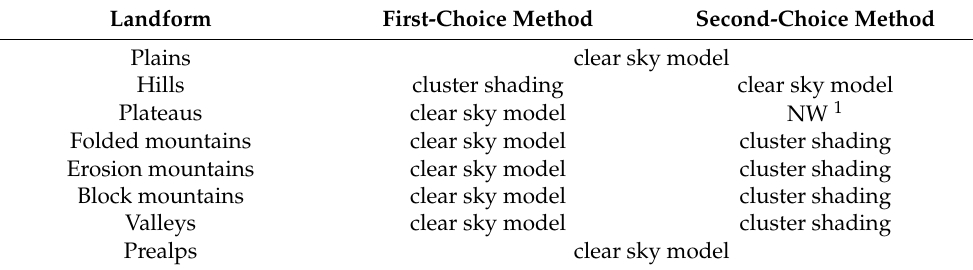
Table 5. Combinations of relief shading techniques to apply depending on